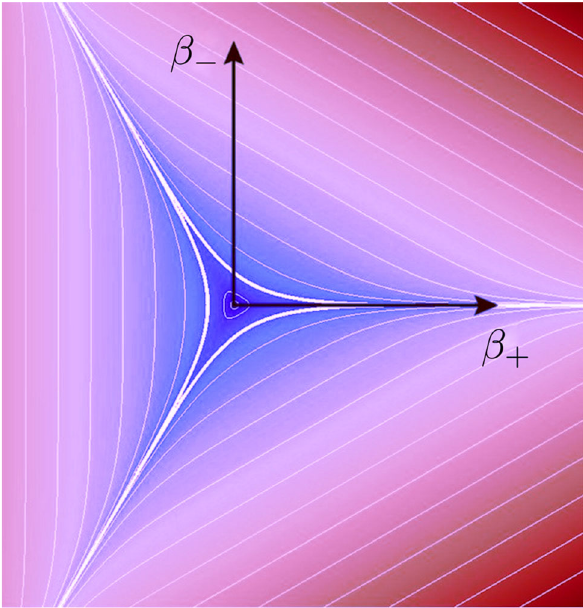
Fig. 2 Equipotentials of the function V B (β ± ) in the (β + ,β − ) -plane. Herewecanseethatfarfromtheoriginthefunctionhasthesymmetryof anequilateraltriangle,whileneartheorigin ( V B < 1 ) theequipotentials are closed